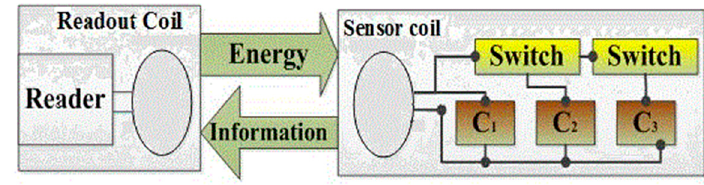
Figure 1. Scheme of LC passive wireless sensor inductive link.